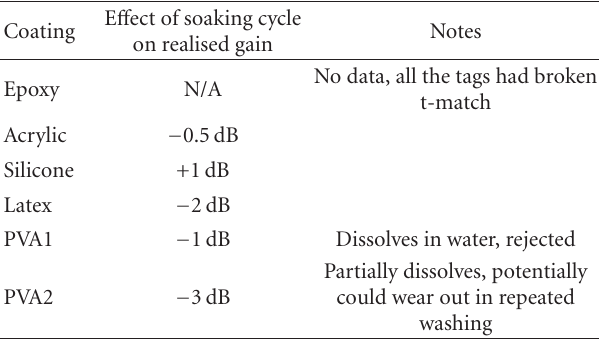
Table 4: Findings of the moisture